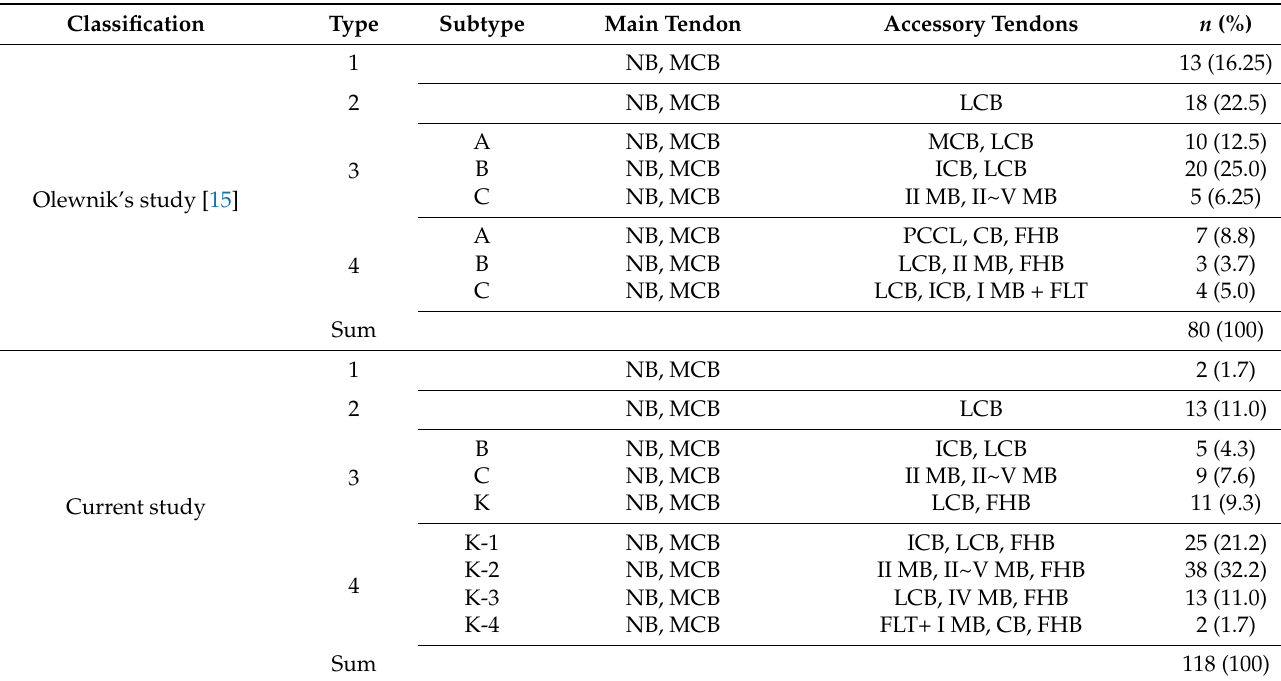
Table 2. Summary of classification for the insertion of the tibialis posterior tendon in current study compared to the previous